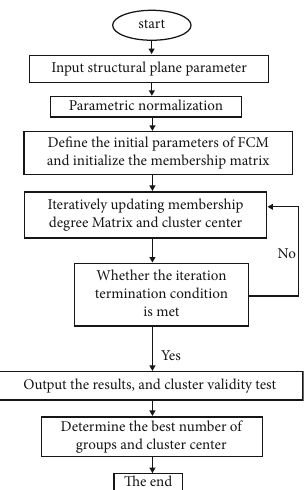
Figure 4: The fl ow diagram of the FCM